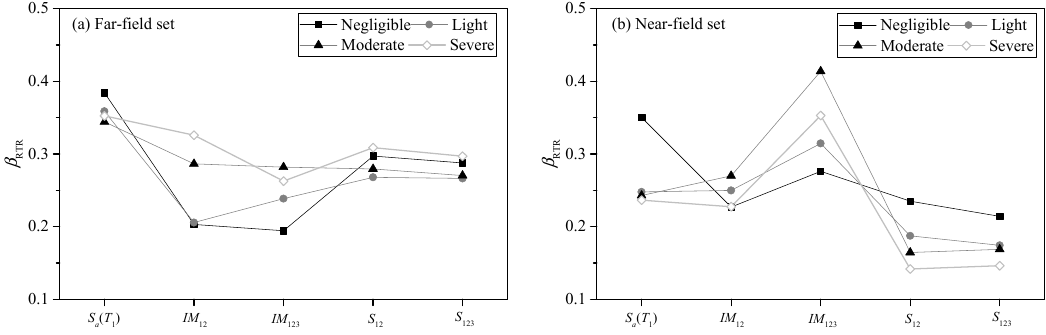
Figure 10. β RTR estimated by S a ( T 1 ), IM 12 , IM 123 , S 12 , and S 123 at different limit states.